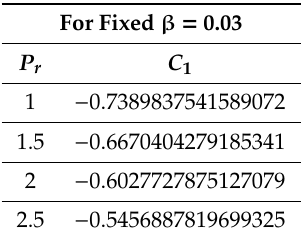
Table 2. Values of P r and C 1 .